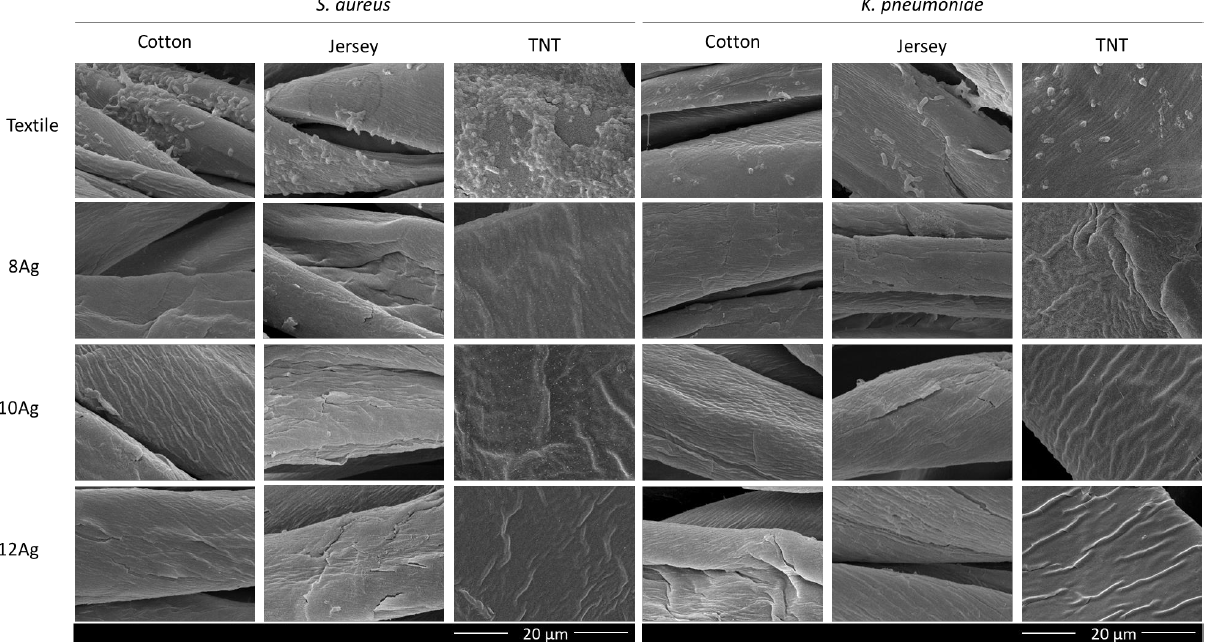
Figure 4. SEM images of coated and uncoated fabrics after ZoI, at a magnification of 5 kx, acquired at 10 kV. at 10